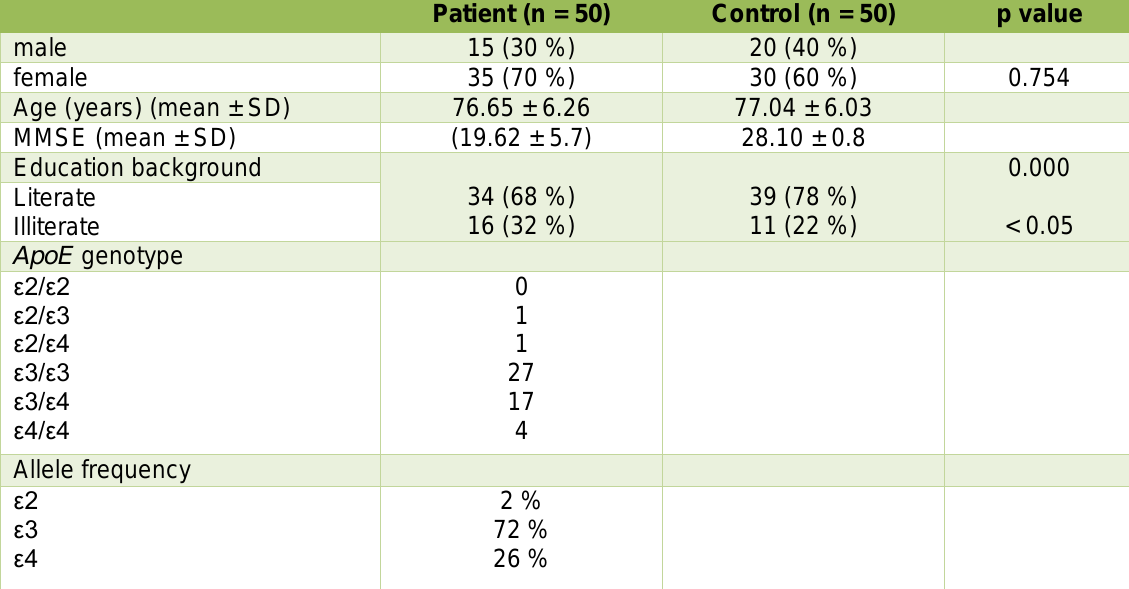
Table 2: Demographic and clinical features of the study